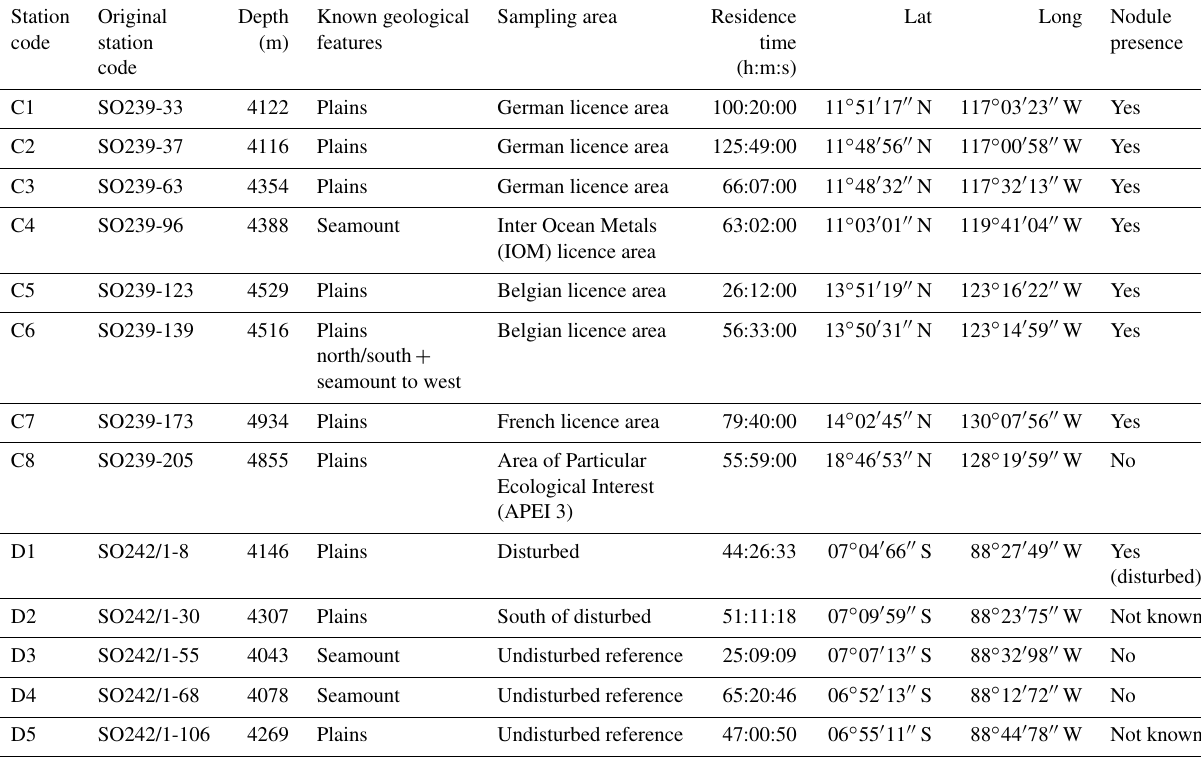
Table 1. Column 1 provides the new the station codes used in this paper in Figs. 1, 3, 4, and 6 and Table 3. The original station codes from cruises SO239 and SO242-1 are in column 2. Depth refers to the trap depth at the time of